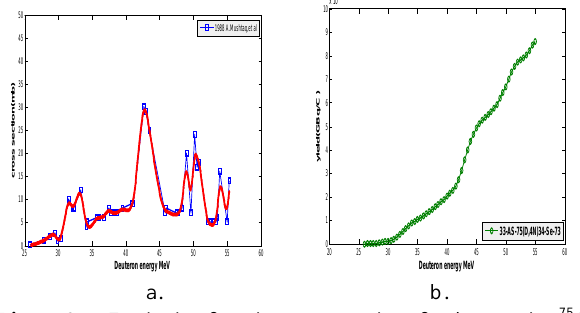
Figure 6 : a. Excitation function cross sections for the reaction 75 As (d,4n) 73 Se. b. Isotopes production yield for the reaction 75 As(d,4n) 73 Se. 3 -Production by Helium-3 particles The excitation functions of the reaction nat Ge ( 3 He,x) 73 Se, were determined by A.Mushtaq, et al (15), for range of energy (12 to 36) MeV Fig.7.a. The isotopes production yield results were shown in Fig.7.b, were determined by equation (2) and the calculated stopping power values by using SRIM code (4).